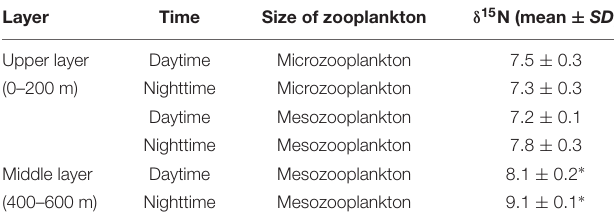
TABLE 4 | δ 15 N of zooplankton in different layers and at different times.